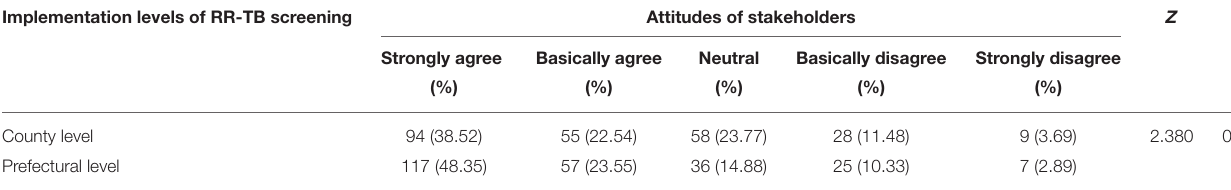
TABLE 8 | Attitudes of stakeholders among service providers toward the implementation levels of RR-TB screening. Implementation levels of RR-TB screening